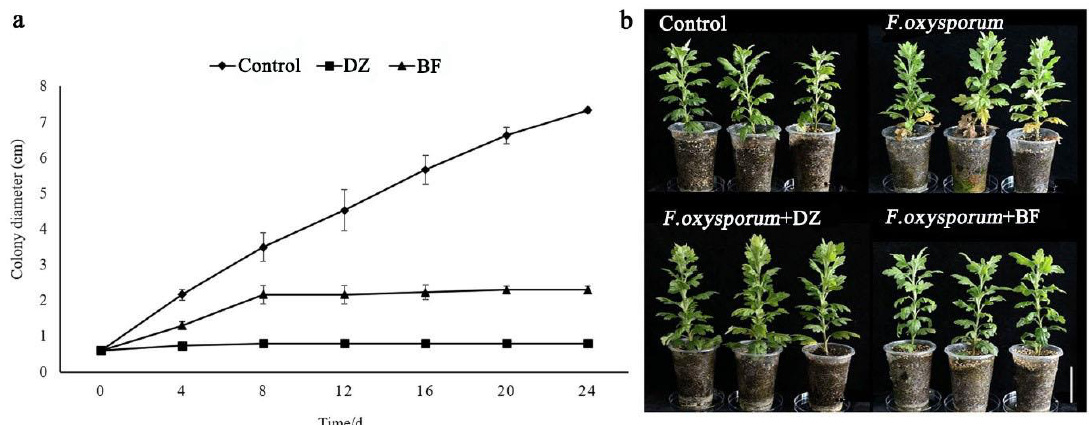
Figure 1. Effects of fungicides on the growth of F. oxysporum CFD-B2. ( a ) Colony diameter of F. oxysporum CFD-B2 on the Potato dextrose agar (PDA) plate with biocontrol agent combined with B. subtilis NCD-2 (BF) and dazomet (DZ) 24 days after inoculation; ( b ) Growth of chrysanthemum 21